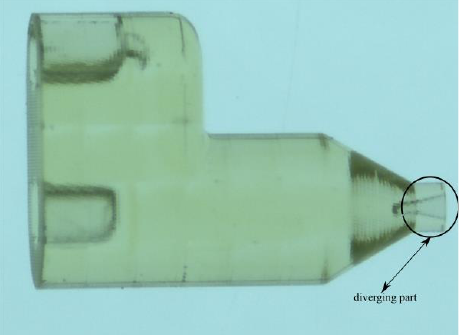
Figure 12. A 3D-printed GDVN with a marked extended diverging outlet orifice.